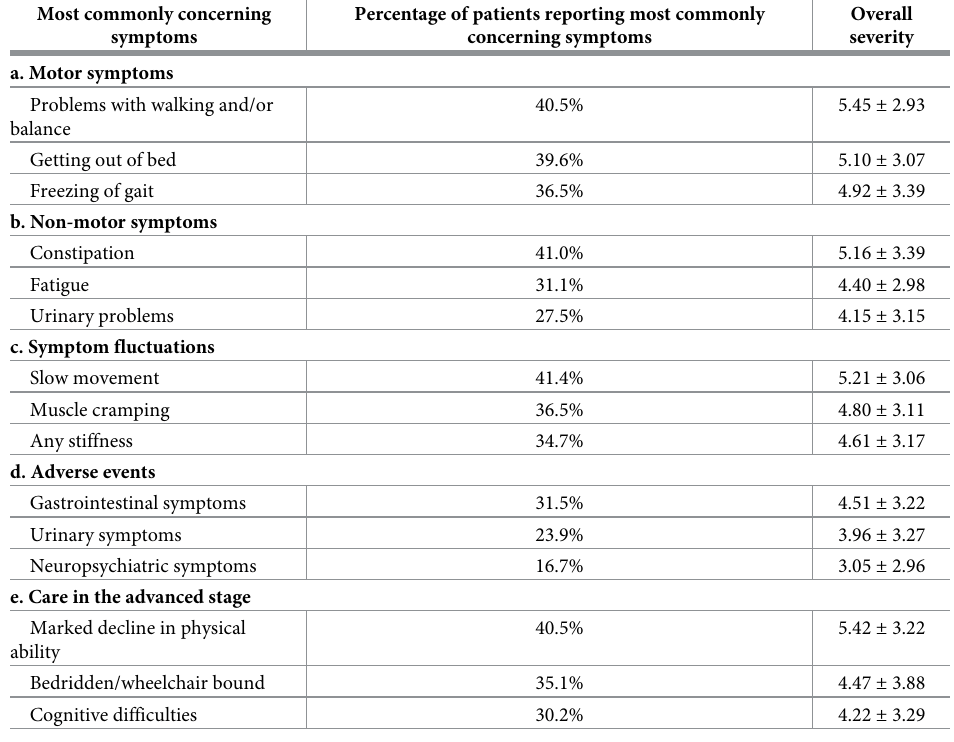
Table 2. PD patients’ greatest concerns regarding (a) motor symptoms, (b) non-motor symptoms, (c) symptoms fluc- tuations, (d) adverse events, and (e) palliative care (n = 222).